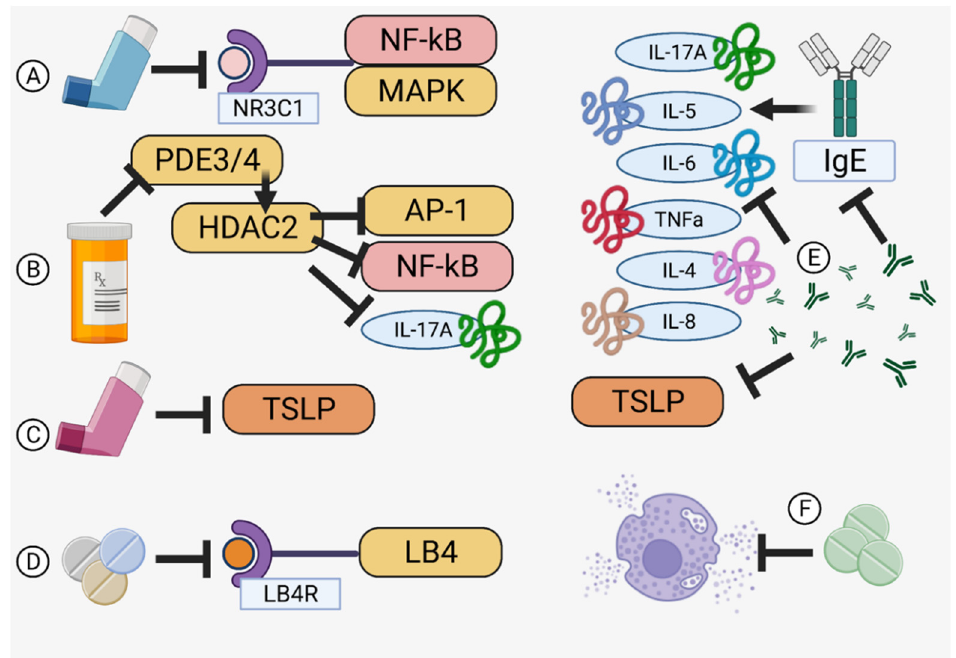
Figure 3. Modes of Action. Specificity for checkpoints in the asthma pathway is the hallmark of an effective therapy. ( A ) Inhaled corticosteroids [47,48], ( B ) theophylline [51,52], ( C ) long-acting beta agonists [57], ( D ) leukotriene receptor antagonists [62], ( E ) monoclonal antibodies [66–68], and ( F ) anti-histamines [71,72] offer diverse targeting specific to halting airway inflammation. Created in BioRender.com.